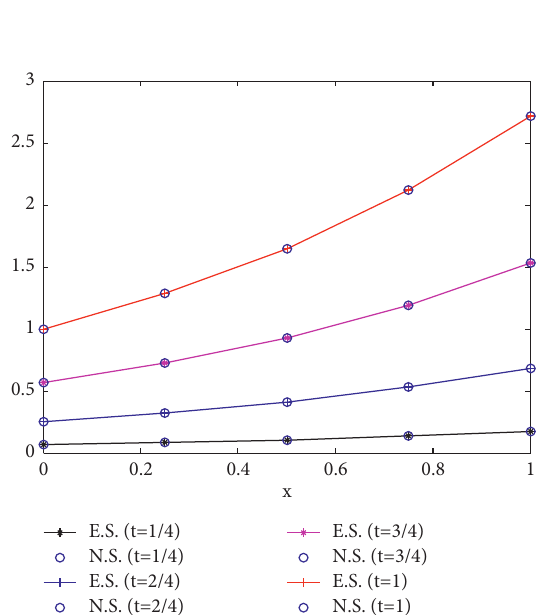
Figure 1: When α � 0 . 5, β � 0 . 6, and τ 2 � h 4 � ( 1/256 ) , numerical methods (24)–(26) are utilized to compare the numerical solutions (N.S.) of problems (73)–(75) with the exact solutions (E.S.) of problems (73)–(75) in t � ( 1/4 ) , ( 2/4 ) , ( 3/4 ) , 1.